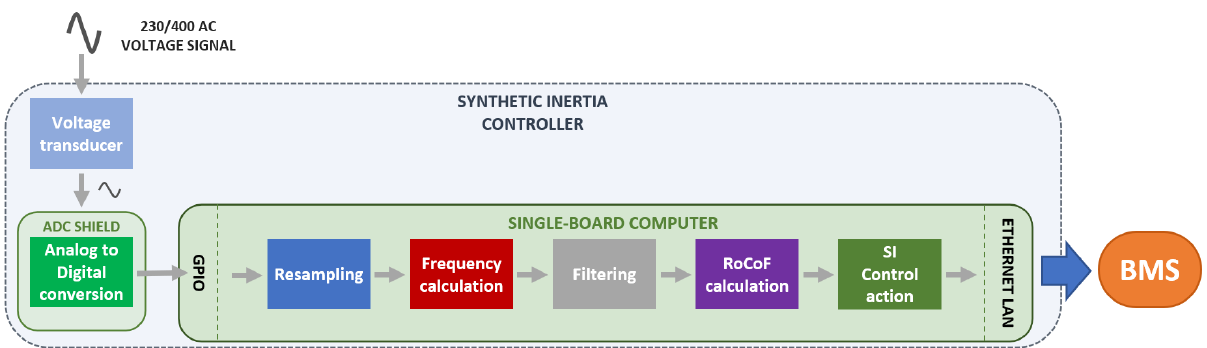
Figure 1. Scheme of the investigated SI